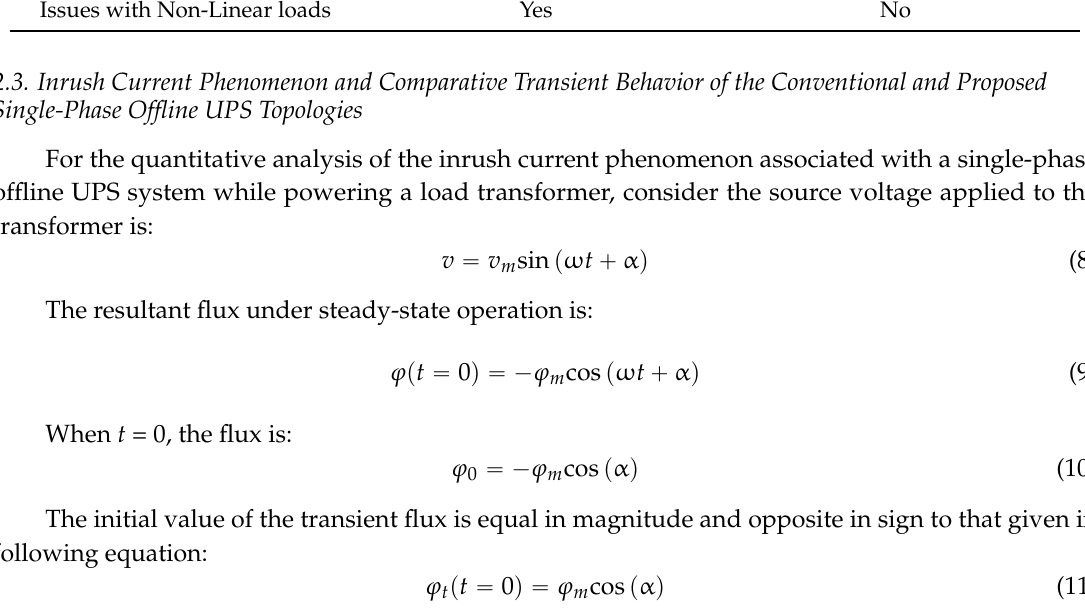
Table 1. Comparison of conventional and proposed offline UPS topologies. Attribute Conventional Topology Proposed Topology Power Application Low Power Applications Low-Medium Power Applications Power Capacity 120% 120% Efficiency High High Design Simple Simple Isolation of Load